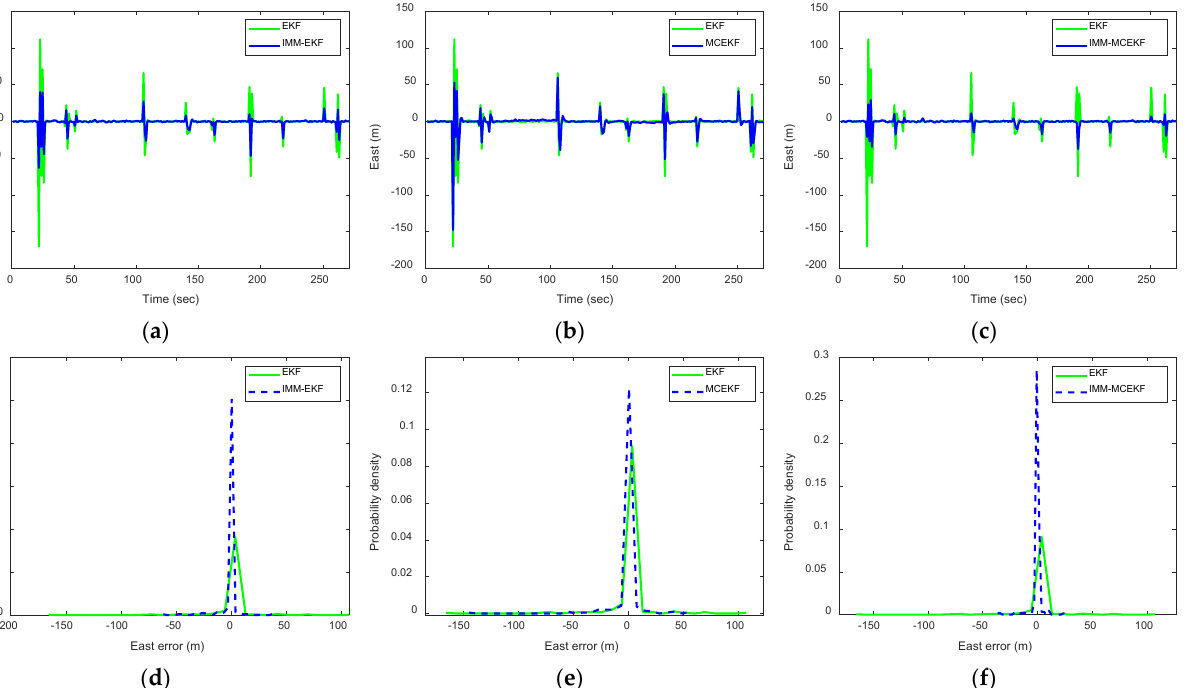
( f ) Figure 8. Comparison between the navigational accuracy and the corresponding pdfs of the north position errors: ( top ) navigational accuracies for EKF vs. ( a ) IMM–EKF, ( b ) MCEKF, and ( c ) IMM–